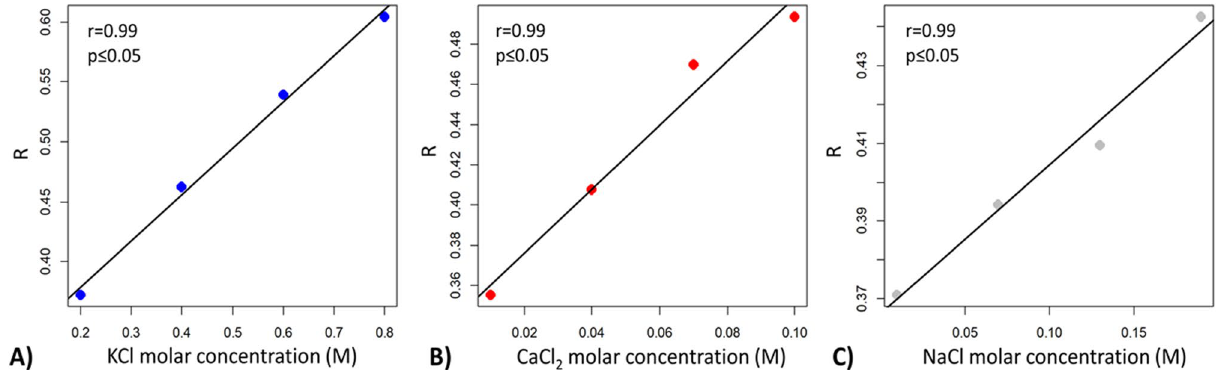
leaves of A. donax